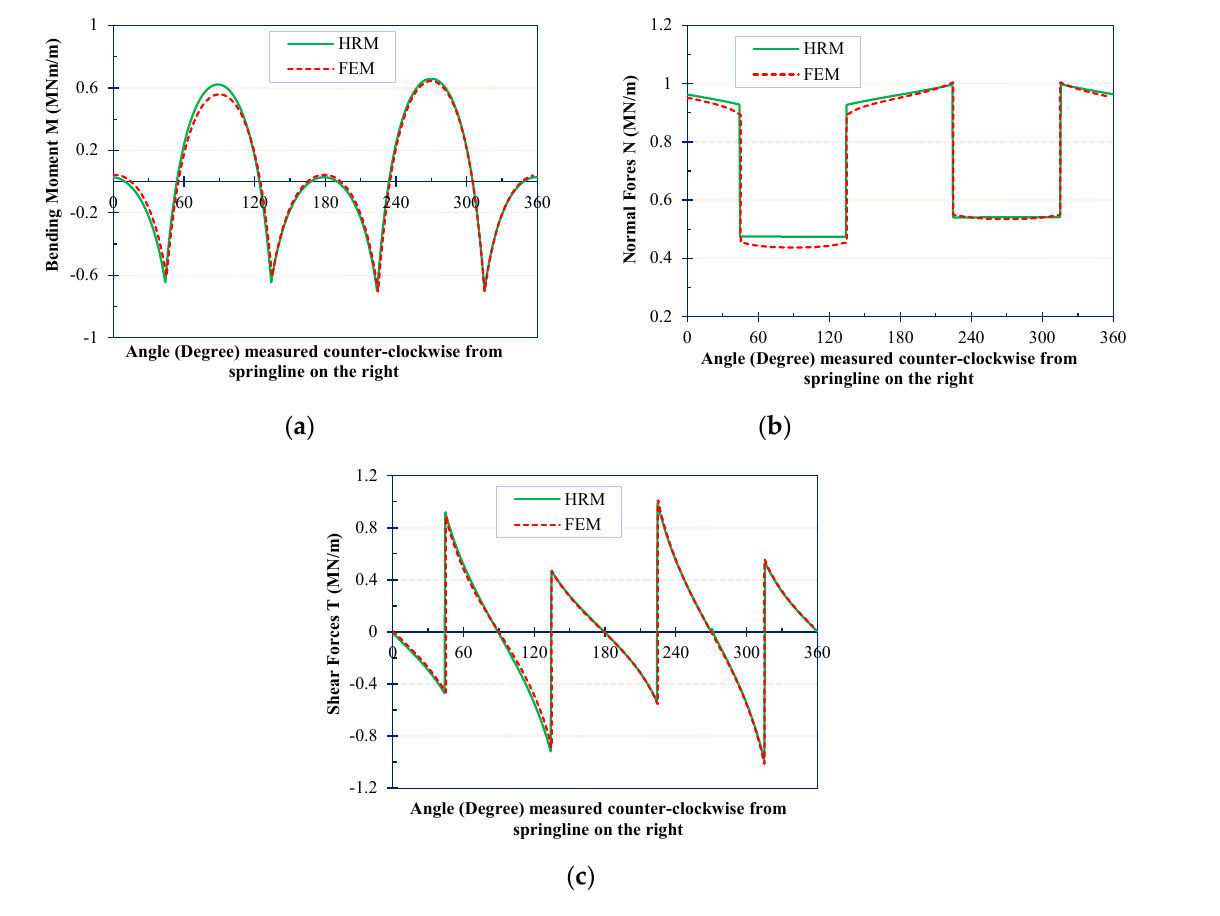
Figure 5. Internal forces in the square tunnel lining: ( a ) Bending moments M; ( b ) Normal forces N; ( c ) Shear forces T.